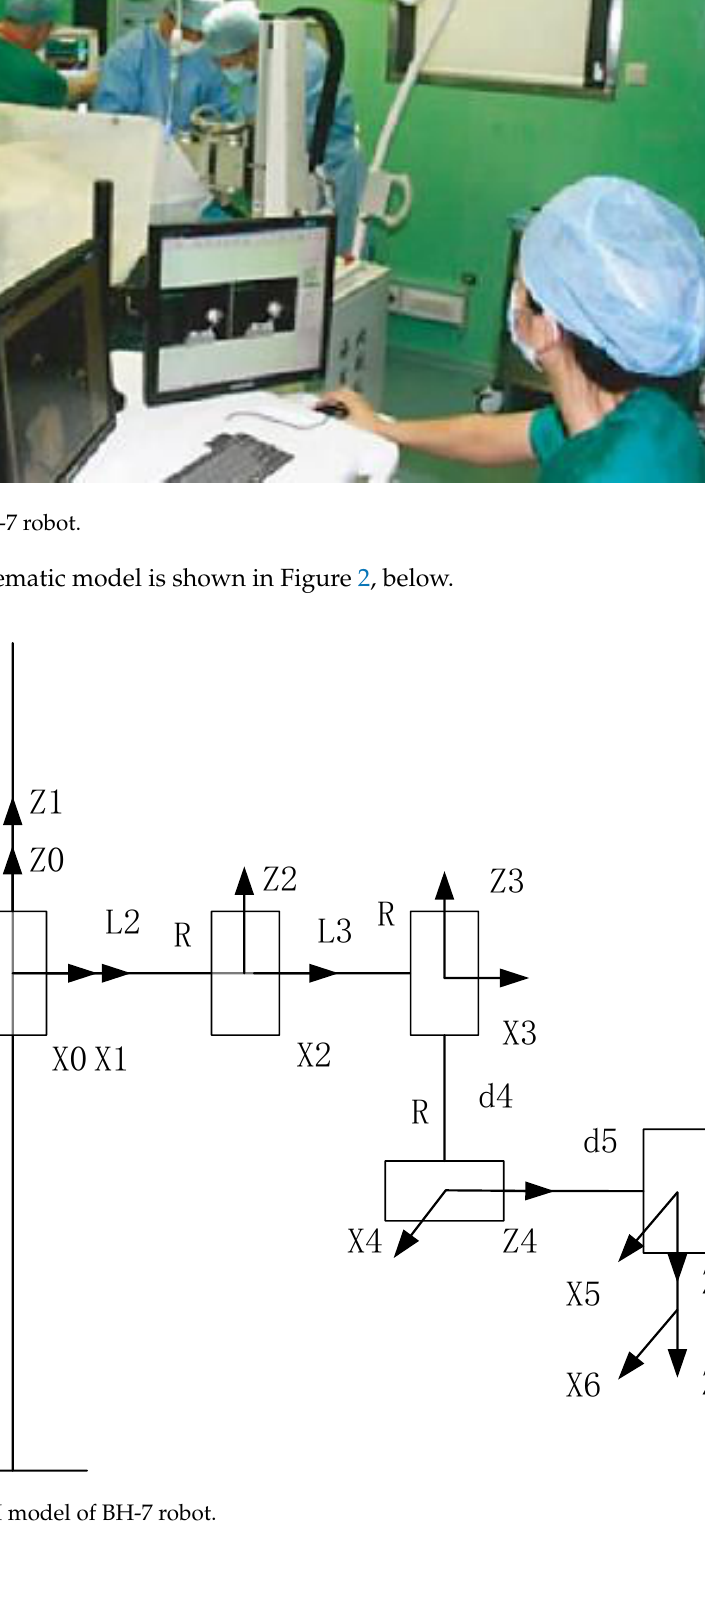
Figure 2. DH model of BH-7 robot.